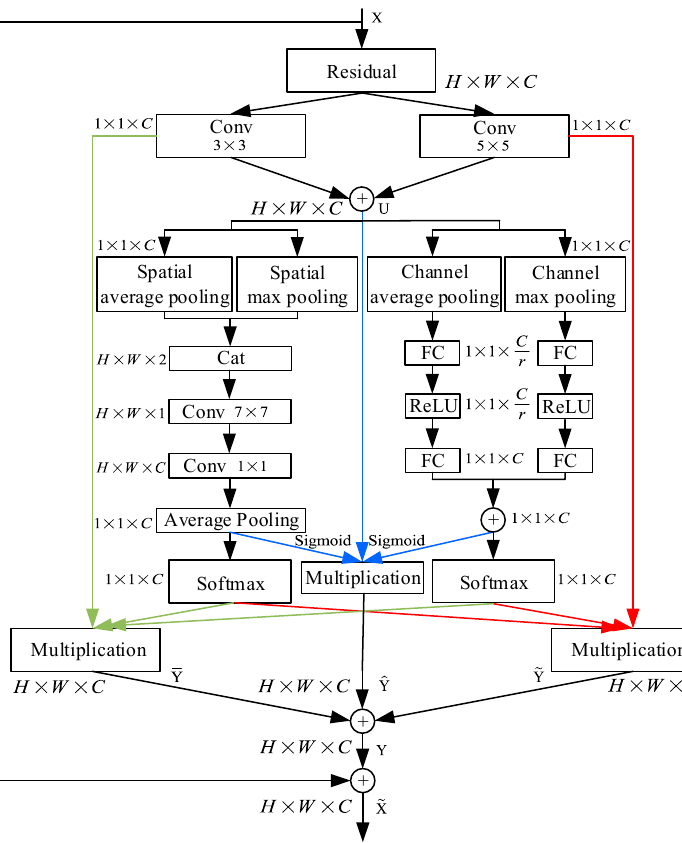
Figure 4. The schema of an FSRF-ResNet module.